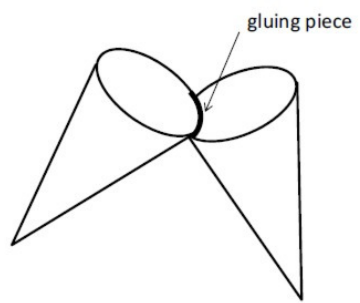
Figure 10 . The two cones can be glued together at the common edges.